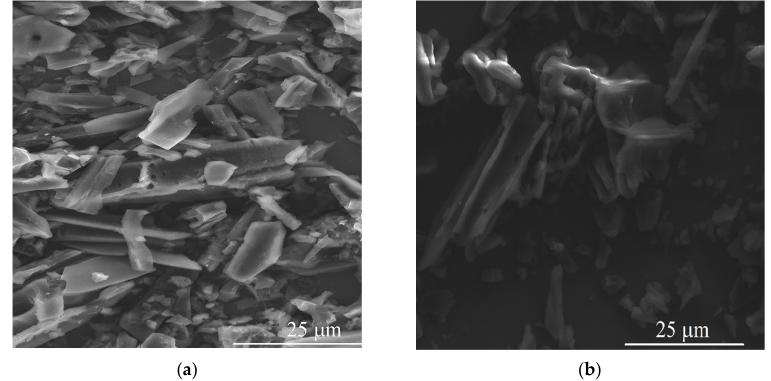
Figure 2. ( a ) SEM images of untreated RC; ( b ) and RC after acid functionalization.